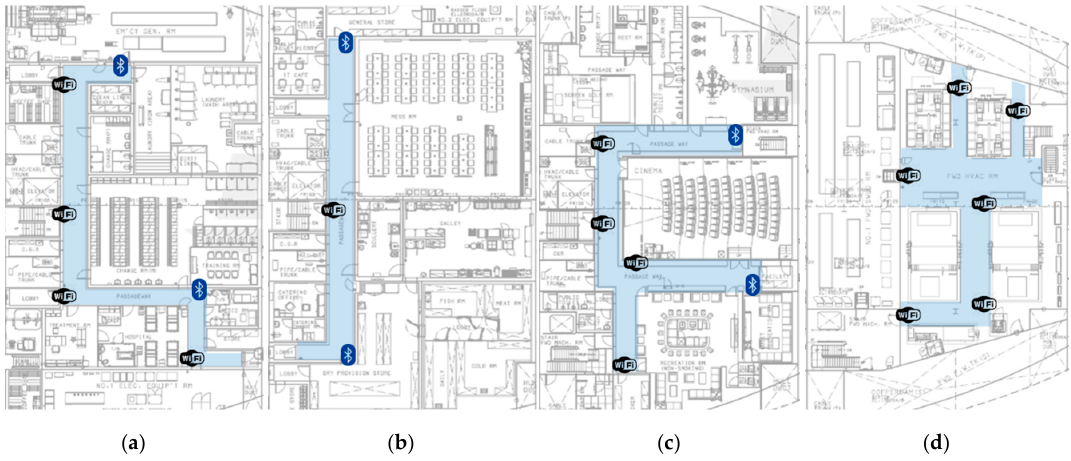
Figure 9. Hybrid positioning test space and access point (AP) beacon locations: ( a ) main deck; ( b ) A deck; ( c ) first deck; ( d ) second deck.